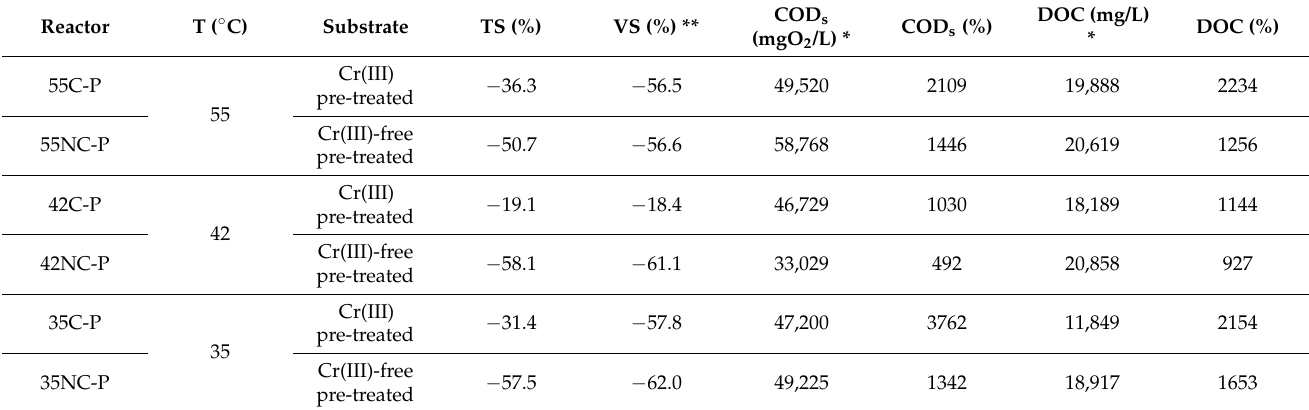
Table 2. Degradation of solid (TS) and volatile solid (VS) and solubilisation of pre-treated leather